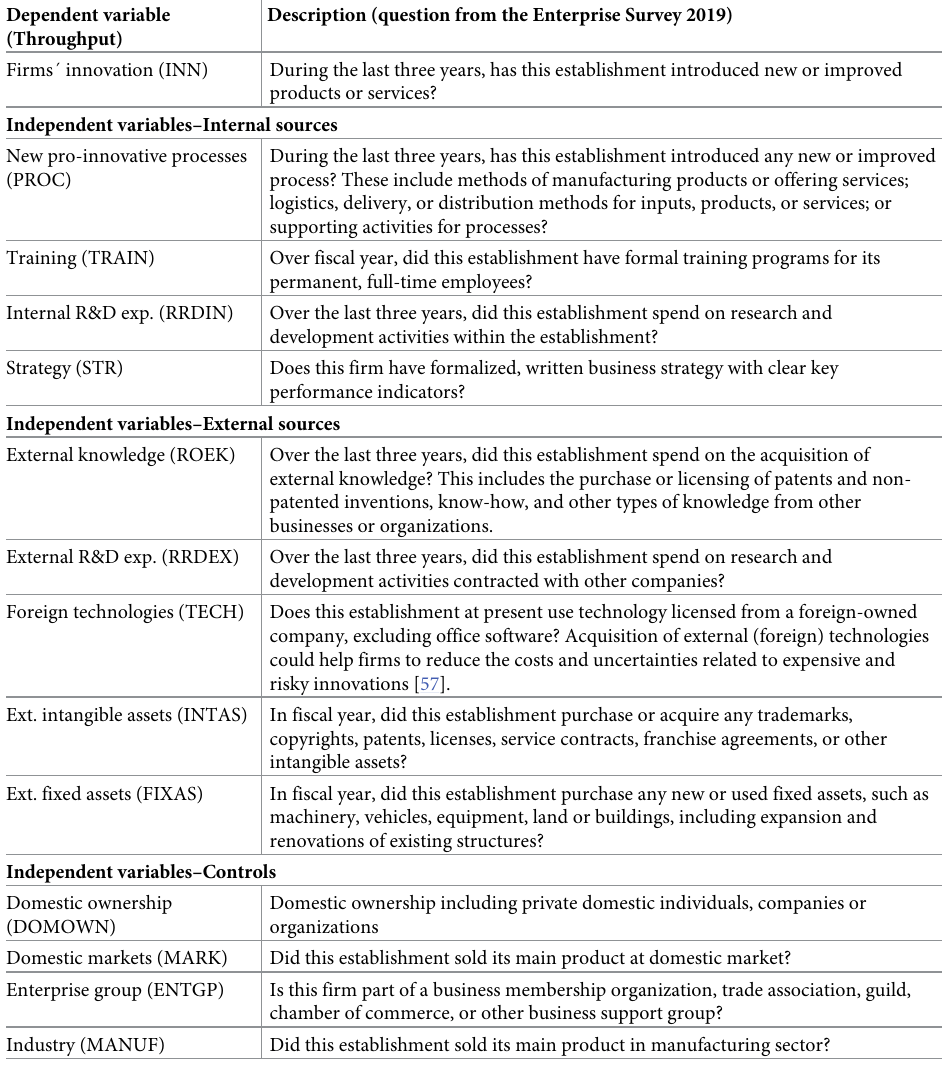
Table 2. Variables of the proposed